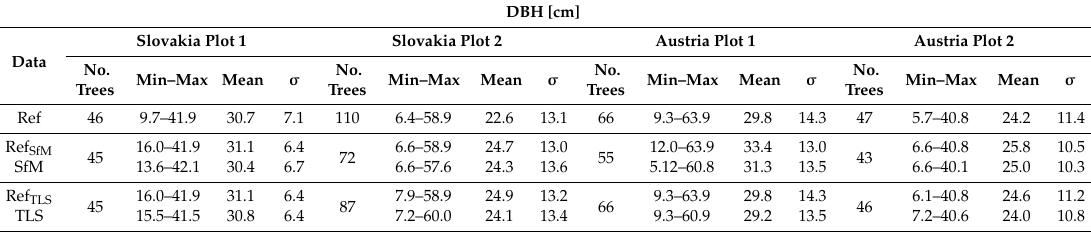
Table A1. A comparison between measured DBH (Ref) and estimated DBH from SfM and TLS point cloud. Ref SfM and Ref TLS indicate the trees measured by caliper that correspond to the SfM and TLS DBH estimates,